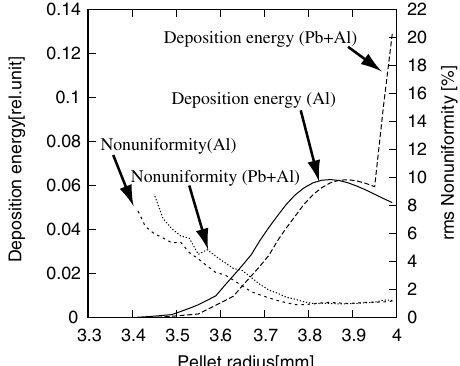
FIG. 9. The deposition energy of beam particles in the rela- tive unit and rms nonuniformity at each surface in the case with the temperature effect for the Al and the Pb (cid:1) Al layer targets for the chamber radius of 5 m, 120-beam system, and the semi-Gaussian